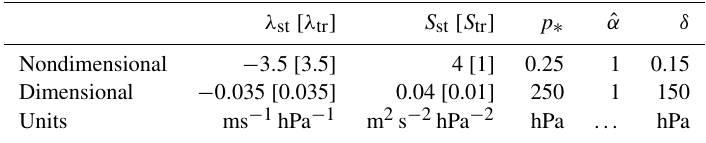
Table 1. Setup of sharp CTL and smooth CTL experiments, as described in the text. λ st [ λ tr ] S st [ S tr ] p ∗ ˆ α δ Nondimensional − 3 . 5 [3.5] 0.25 0.15 Dimensional − 0 . 035 [0.035] 0.04 [0.01] 250 1 150 Units ms − 1 hPa −